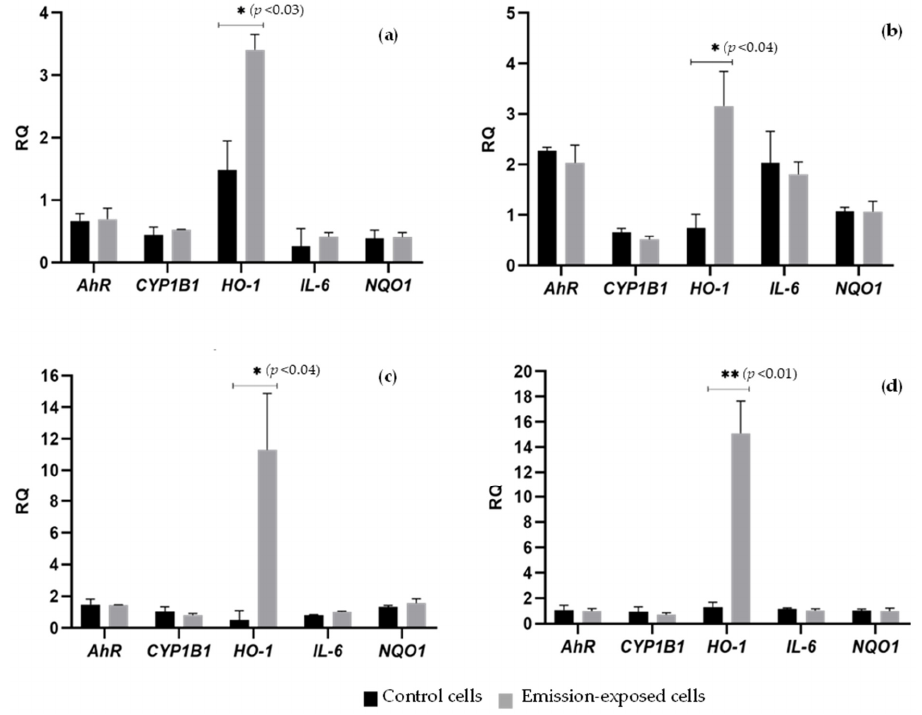
Figure A2. Gene expression of selected genes during the different biofuel blend emission tests. Biofuels I and III gene expression were analyzed just after the end of the tests ( a , b ), while for biofuels II and IV the cells were left to recover for 1 h after the end of the exposures ( c , d ). The recovery period dramatically increased the expression of the antioxidant HO1 gene. All the other genes were not modified.